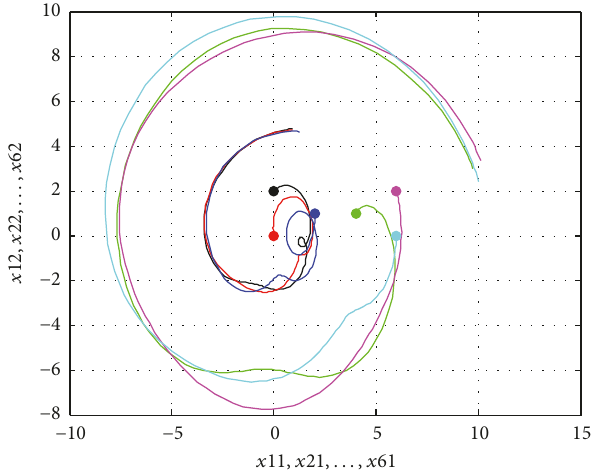
Figure 4: Quasi-consentaneous state trajectories of Example 2 with 𝑡 ∈ [0, 3] . Thick dots denote starting positions.